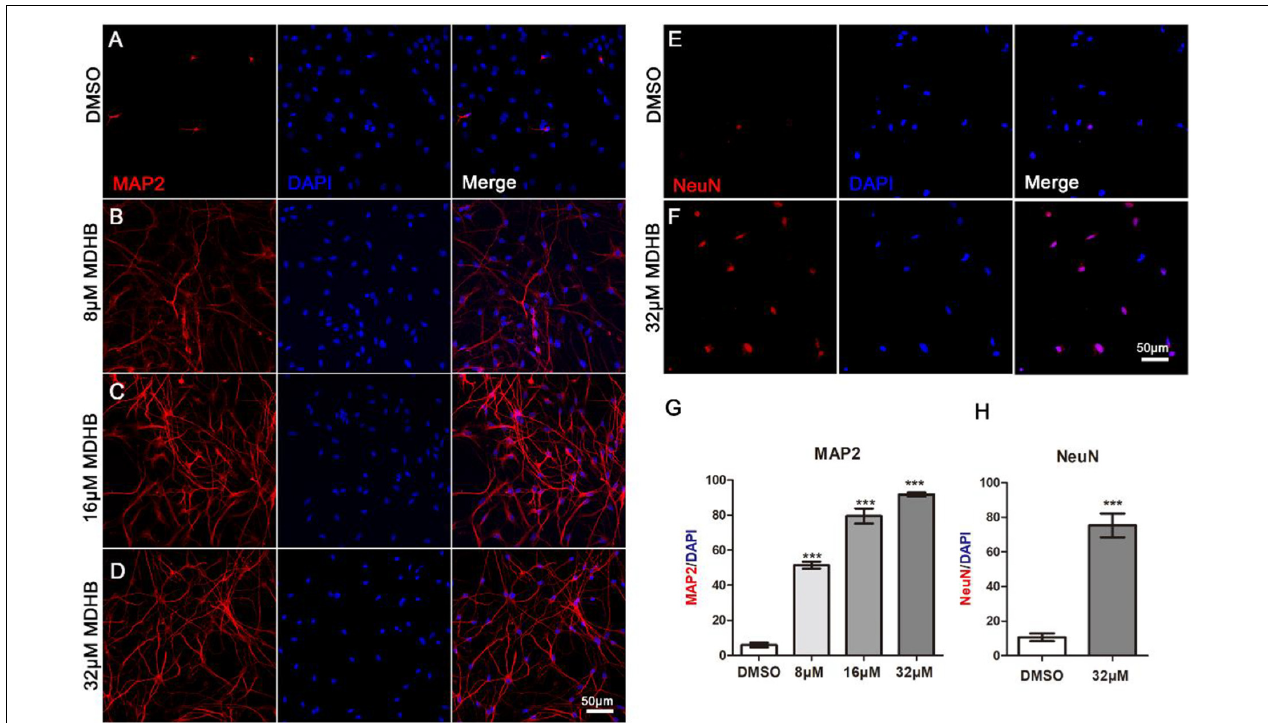
FIGURE 3 | MDHB-induced immature neurons form mature neurons. (A–F) After 9 days of NSCs differentiation induced by MDHB, the new cells were fluorescently stained, the cells with MAP2 and NeuN were dyed red and the cell nuclei with DAPI was dyed blue; (G,H) the statistical results of mature neurons differentiated by MDHB-induced NSCs ( ∗∗∗ P < 0.001, compared with DMSO group, n =